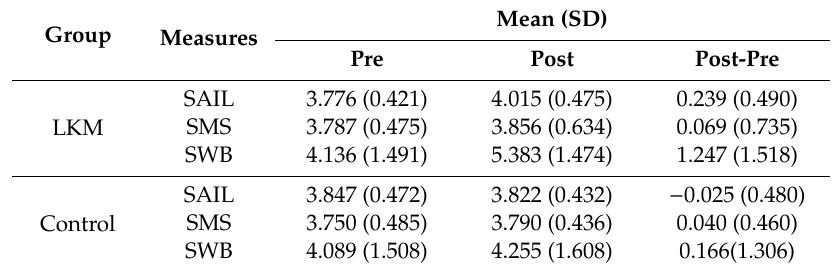
Table 2. Means and standard deviations for each measure of each group, pre and post assessment.